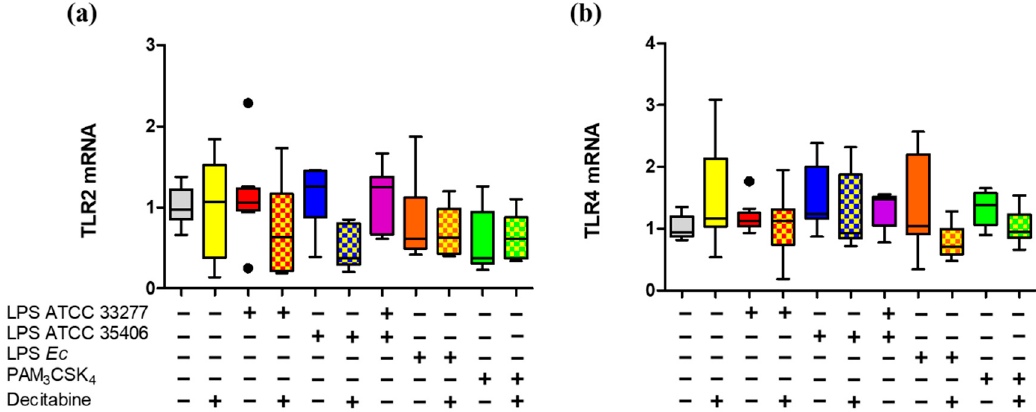
Figure 5. TLR2 and TLR4 gene expression in LPS or lipopeptide-stimulated macrophages in vitro treated with decitabine. Box and whisker plots represent the median and interquartile range of relative gene expression of ( a ) TLR2 and ( b ) TLR4. THP-1 macrophages in vitro were treated with decitabine for 24 h and stimulated for 2 h with LPS or PAM 3 CSK 4 . Relative gene expression was normalized relative to 18S rRNA and expressed as the difference between 2 – ΔΔ Ct . Experiments were performed in triplicate. Data were analyzed by the Kruskal-Wallis test. ( ● ) Represents outlier data. ( n = 3).